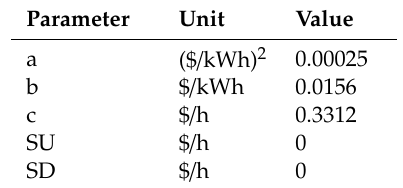
Table 2. Diesel generator parameters.